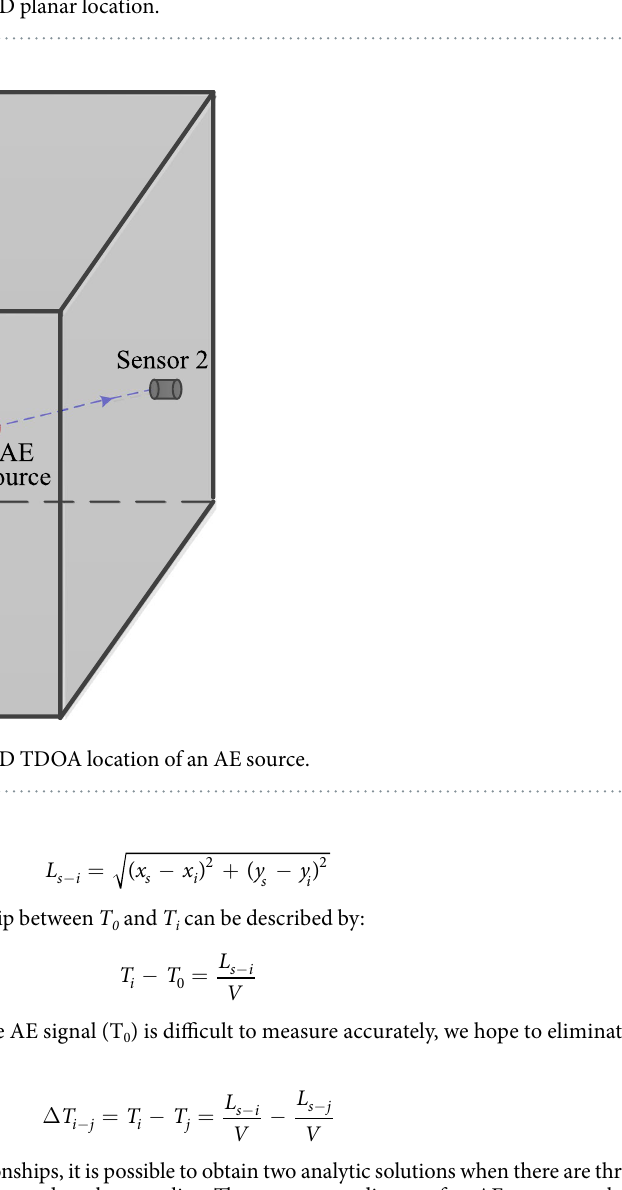
Figure 2. The schematic of the 2D planar location.